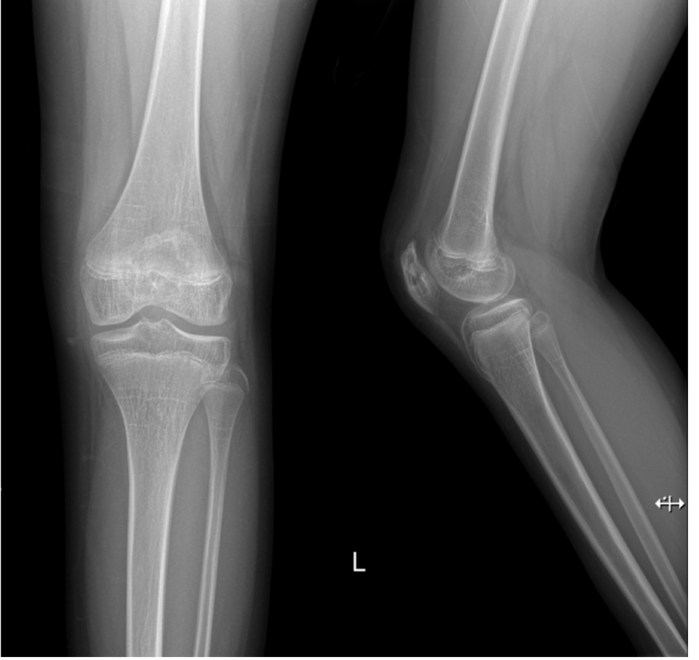
Figure 8. Simple radiograph of the left knee performed at the postoperative 15th month indicated bony recovery of the